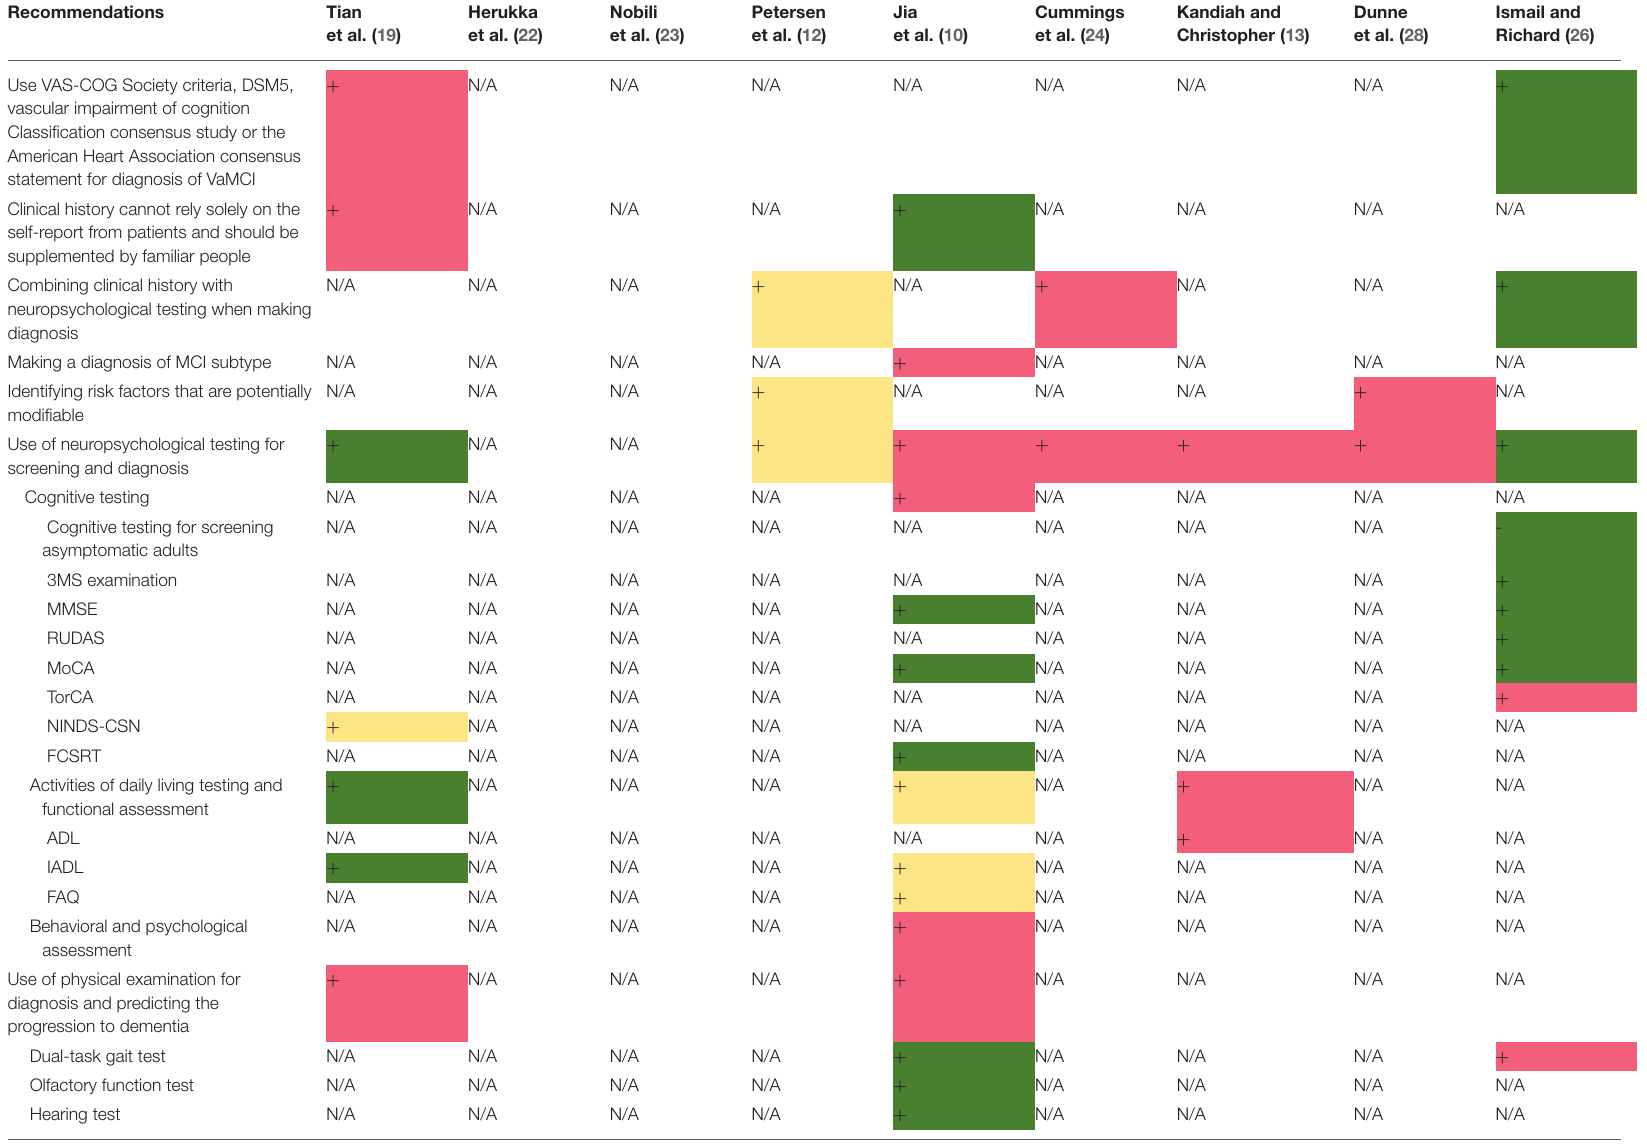
TABLE 3 | Summary of recommendations for screening and